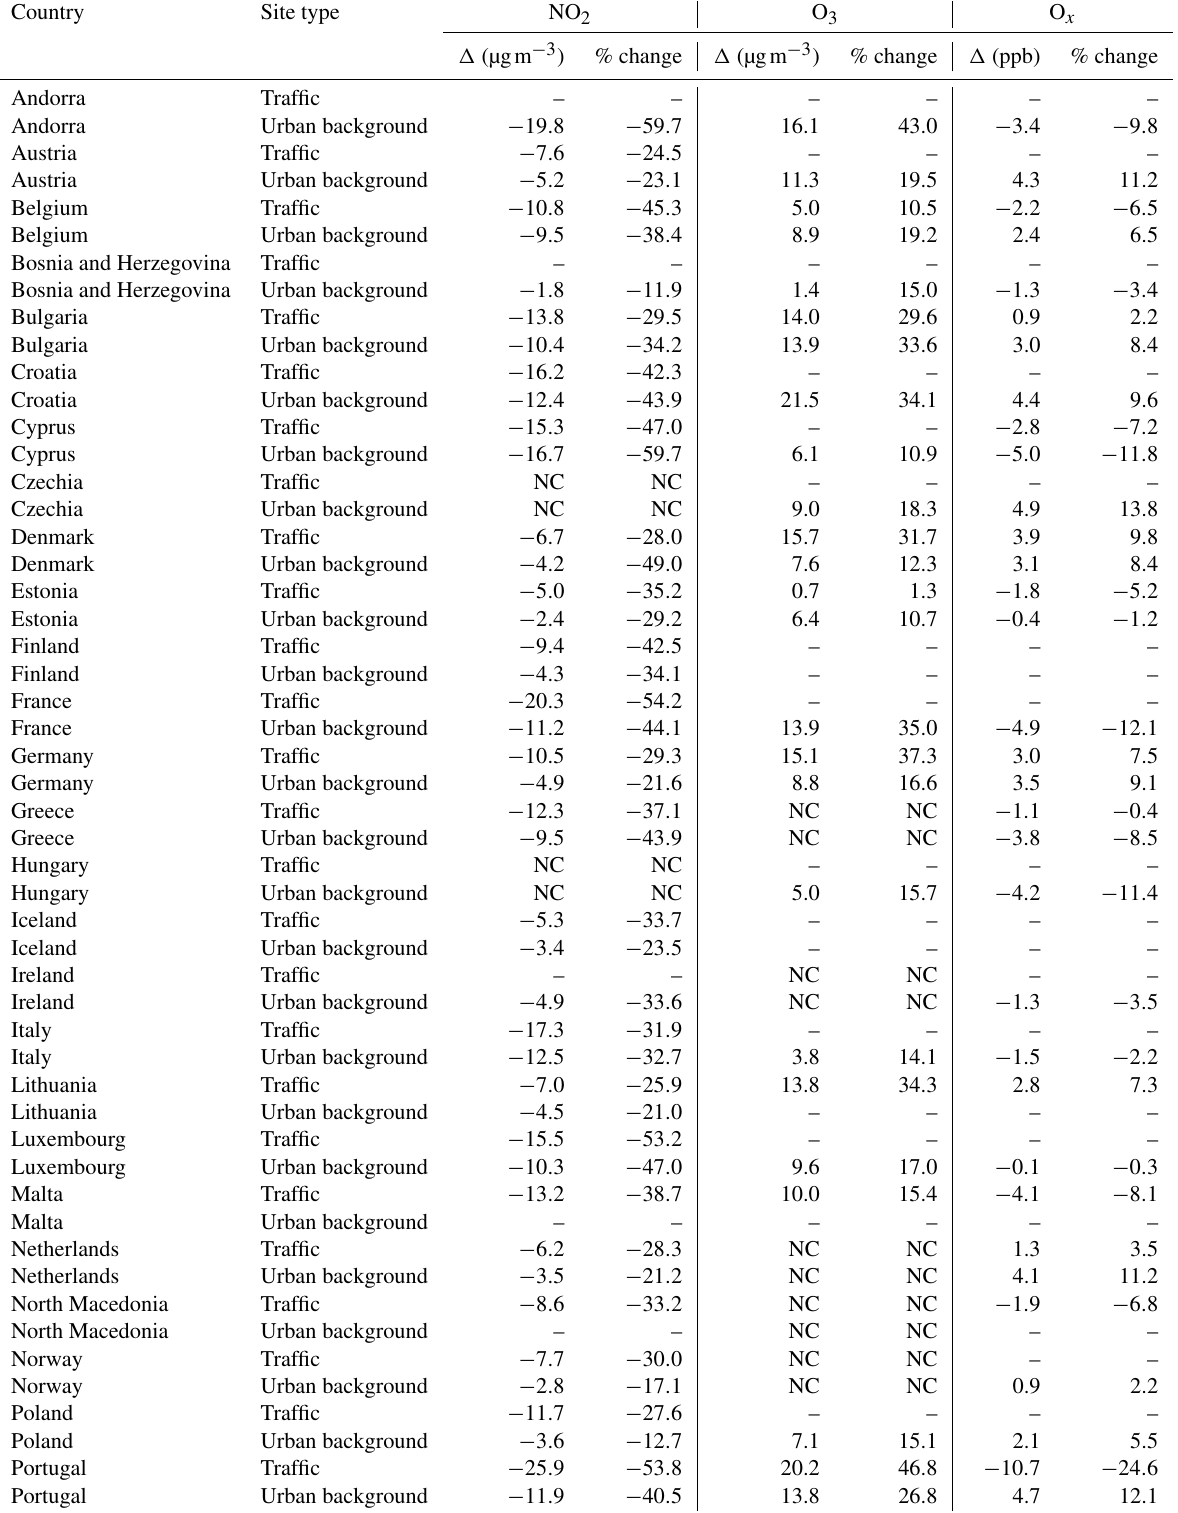
Table 1. Mean concentration deltas or differences and percentage changes in NO 2 , O 3 , and O x for different countries and site types attributed to COVID-19 lockdown measures in March 2020. Missing values indicate that there were no data available, and NC indicates that no change point was